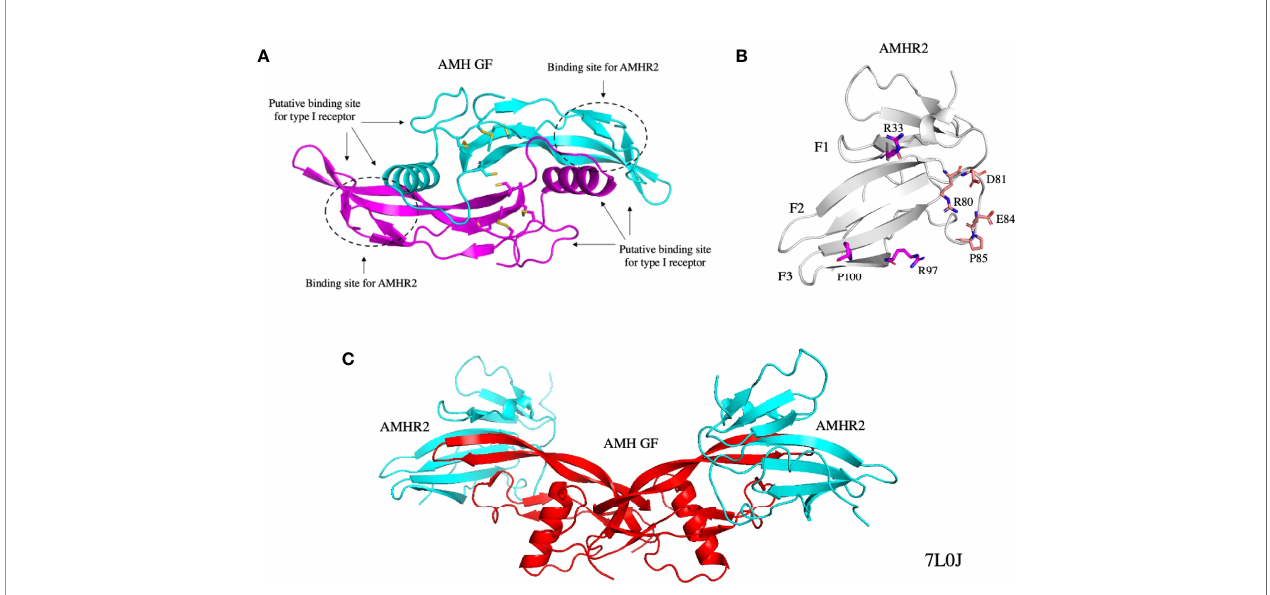
FIGURE 2 | Structures of the AMH GF (A) , AMHR2 ECD (B) , and the AMH GF bound to AMHR2 ECDs (C) . The binding sites of the type I receptor and AMHR2 on the AMH GF are indicated and some of the residues on the AMHR2 ECD that contact the AMH GF are shown as sticks. All structures were generated from PDB 7L0J (29). GF, growth factor; ECD, extracellular